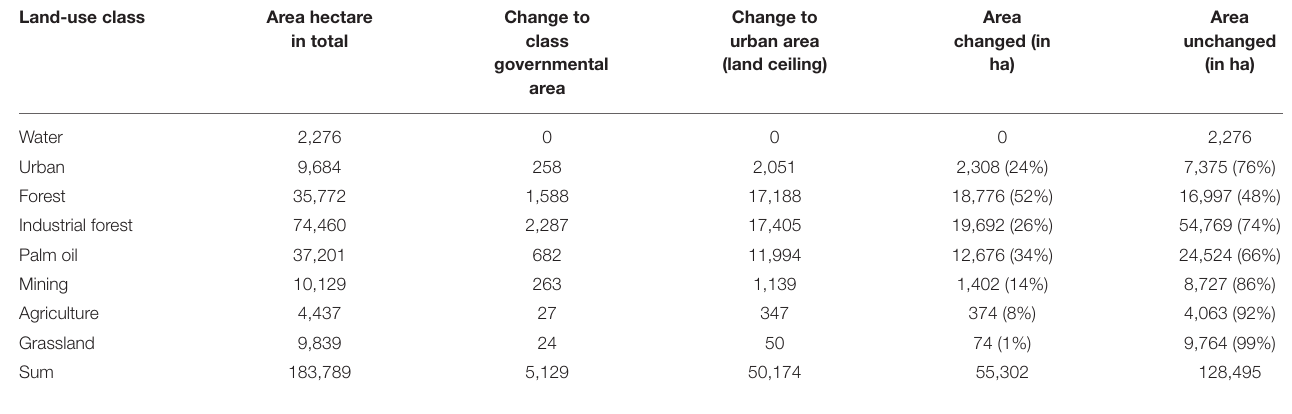
TABLE 3 | Overview of land-use changes in the IKN